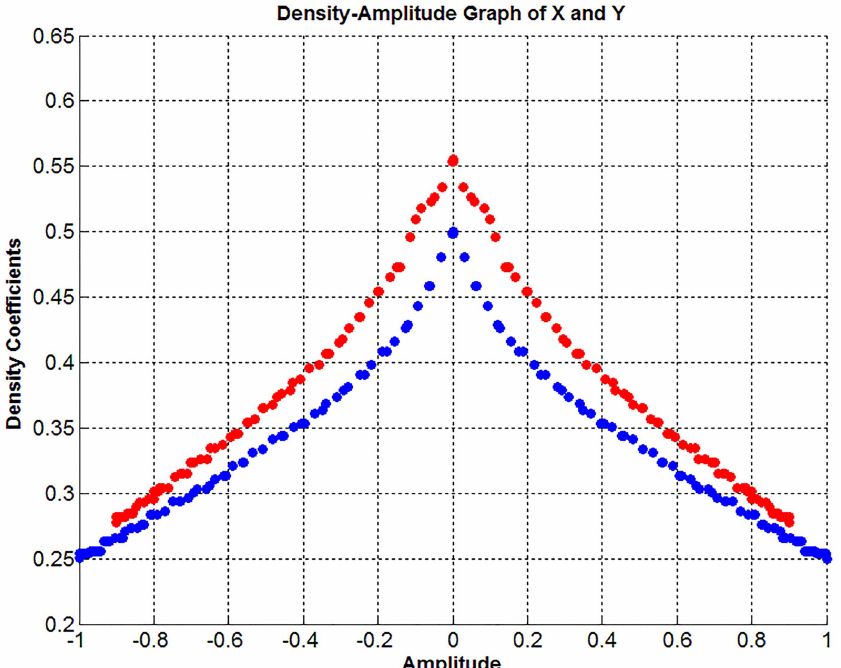
Fig 6. Density-amplitude domain representation of 3rd channel data (Blue: class-1 data, Red: class-2 data).